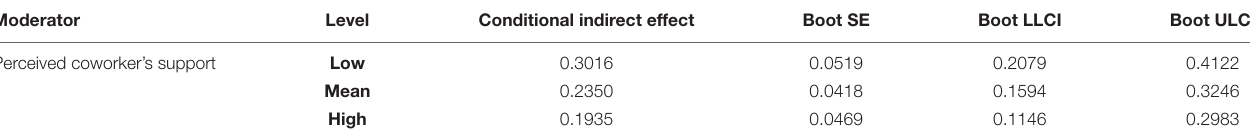
TABLE 10 | Conditional indirect effects from active-aggressive abusive supervision to compulsory citizenship behavior for different levels of perceived coworker’s support.